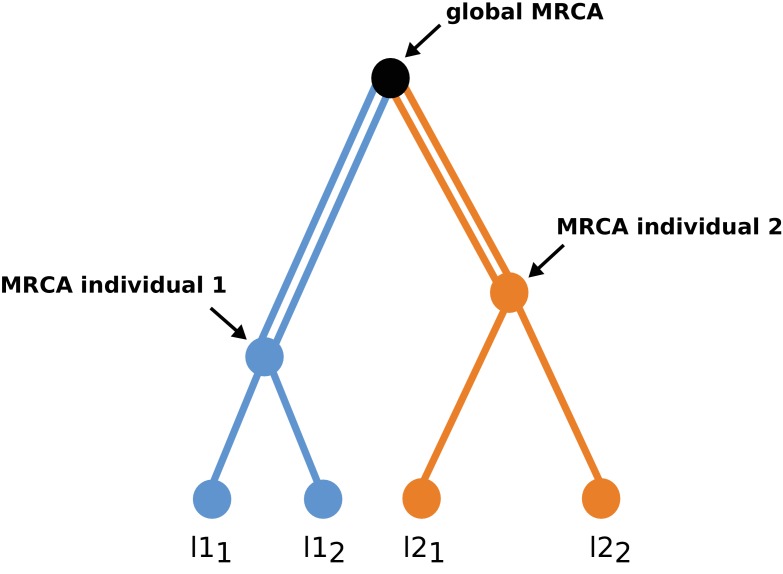
Genealogy of a sample of two diploid individuals at an arbitrary locus.It illustrates the fact that the expected number of derived mutations counted as the number of heterozygous sites plus two times the number of homozygous sites is the same for the two individuals assuming a constant mutation rate over the whole genealogy. Mutations accumulating over a single line of a given color will appear as heterozygous sites in a given individual, whereas mutations occurring along a double line of the same color will appear as homozygous. Since the orange path has the same length as the blue path, the expected number of mutations accumulated since the global MRCA of the sample will be identical in the two individuals. This argument generalizes to an arbitrary number of individuals, and this irrespective of the fact that these individuals belong to the same population or not, which includes the case where different populations have different demographic histories. The same argument thus holds for any locus and can thus be extended to a collection of loci with similar mutation rate. Differences in the number of derived alleles between individuals from different populations should thus reflect differences in mutation rates, selection intensity or generation time between populations.